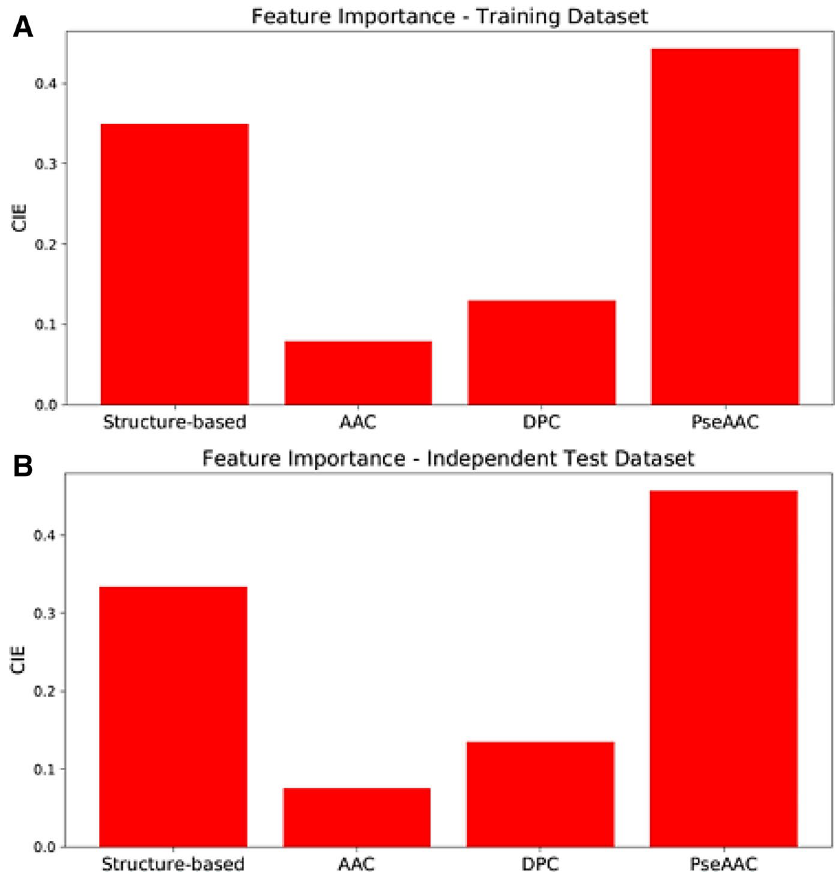
Figure 5. Normalized cumulative information entropy (CIE) provided by structure-based, AAC, DPC, and PseAAC descriptors, and calculated by ERT algorithm. ( A ) Training dataset; ( B ) independent test